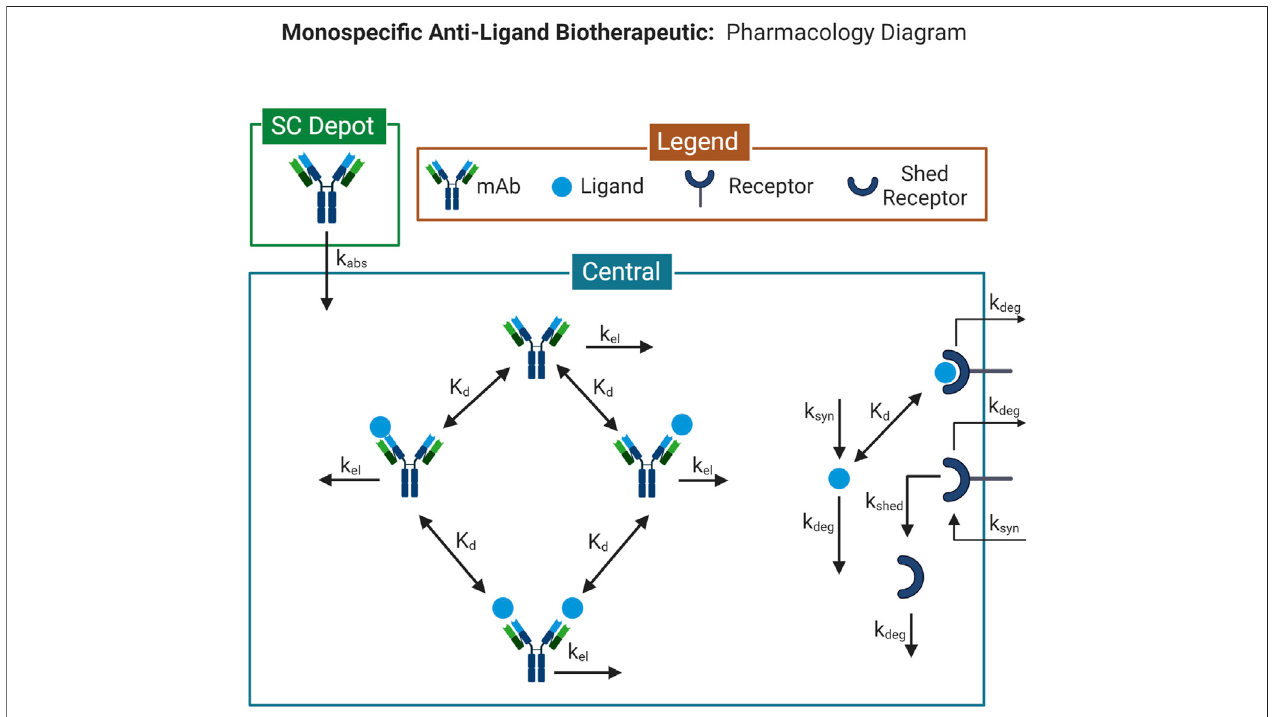
FIGURE1 | Model Diagram forthe 1-compartment monospeci fi c anti-ligand model. Diagramillustrates the species and reactions comprising the pharmacological model describing the interaction between a monospeci fi c anti-ligand antibody and its target. Model diagram was created with